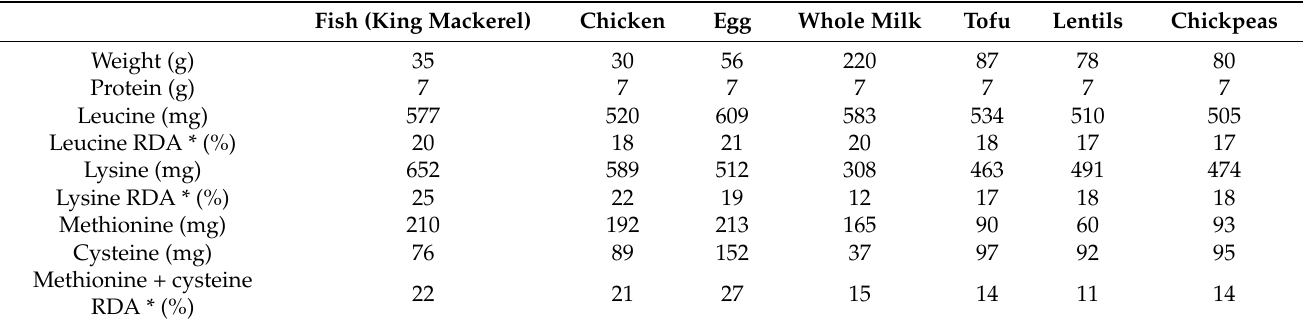
Table 6. Selected essential amino acids of protein food sources (7 g